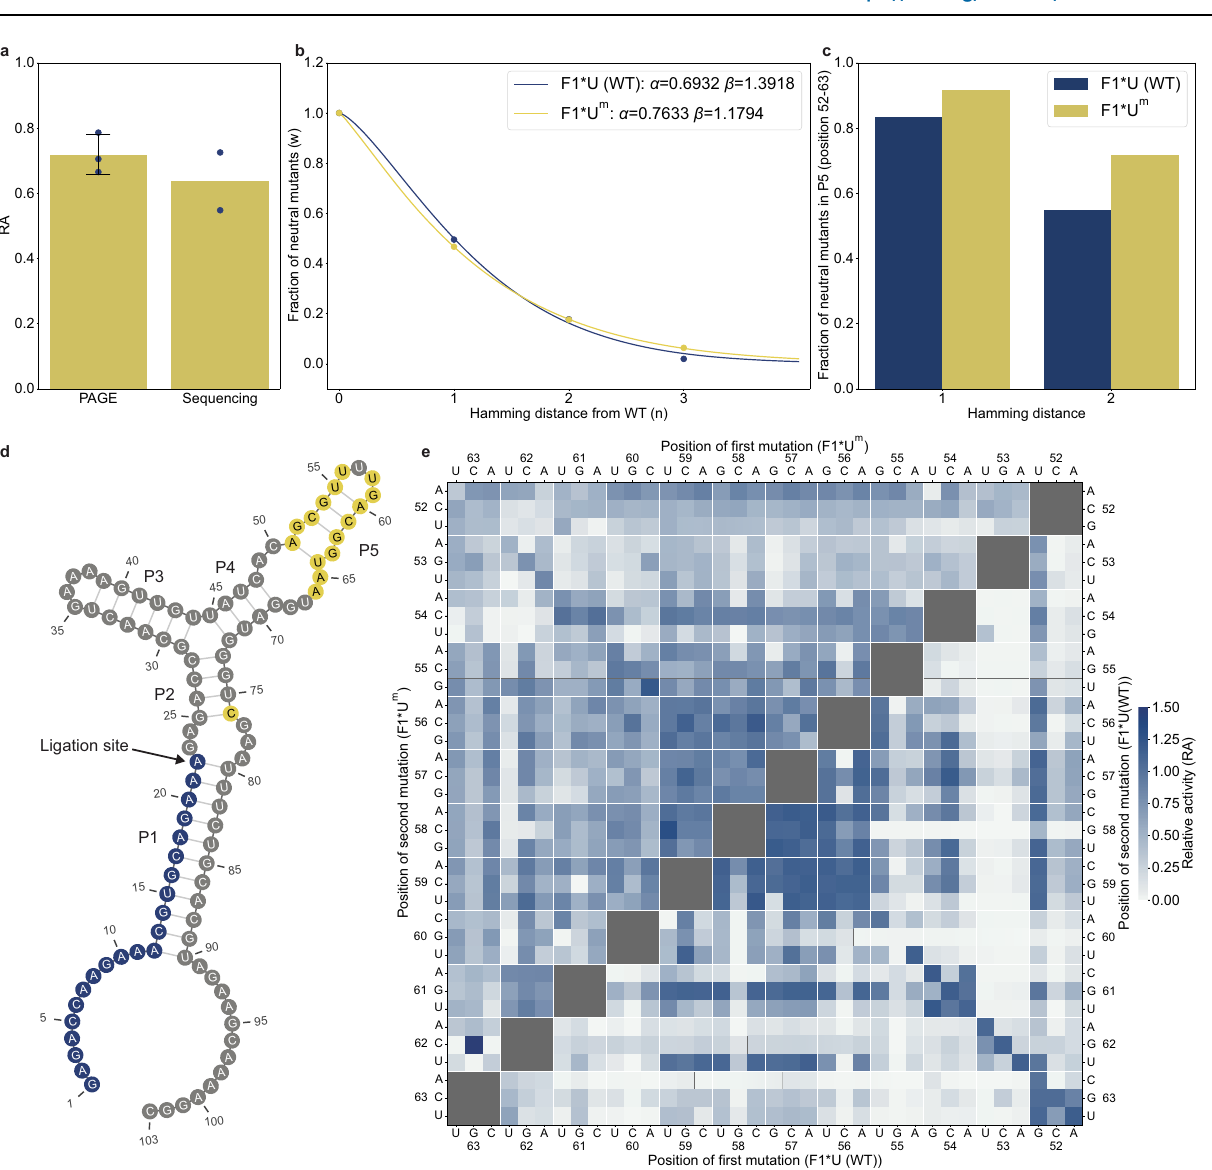
strength of directional epitasis. β >1 indicates an excess of negative epistasis and β <1 indicates an excess of positive epistasis. β equal to 1 indicates a balanced mix ofpositiveandnegativeepistasisorthereisnoepistasis. c Fractionofneutralsingle and double mutants in the P5 stem of F1*U (blue) and F1*U m (yellow). d Predicted secondary structure of the ligated F1*U m by ViennaRNA 2.5.1 software. The 16 mutated positions are yellow, and the substrate is blue. e RA of double mutants in the P5 stem of F1*U (lower triangle) and F1*U m (upper